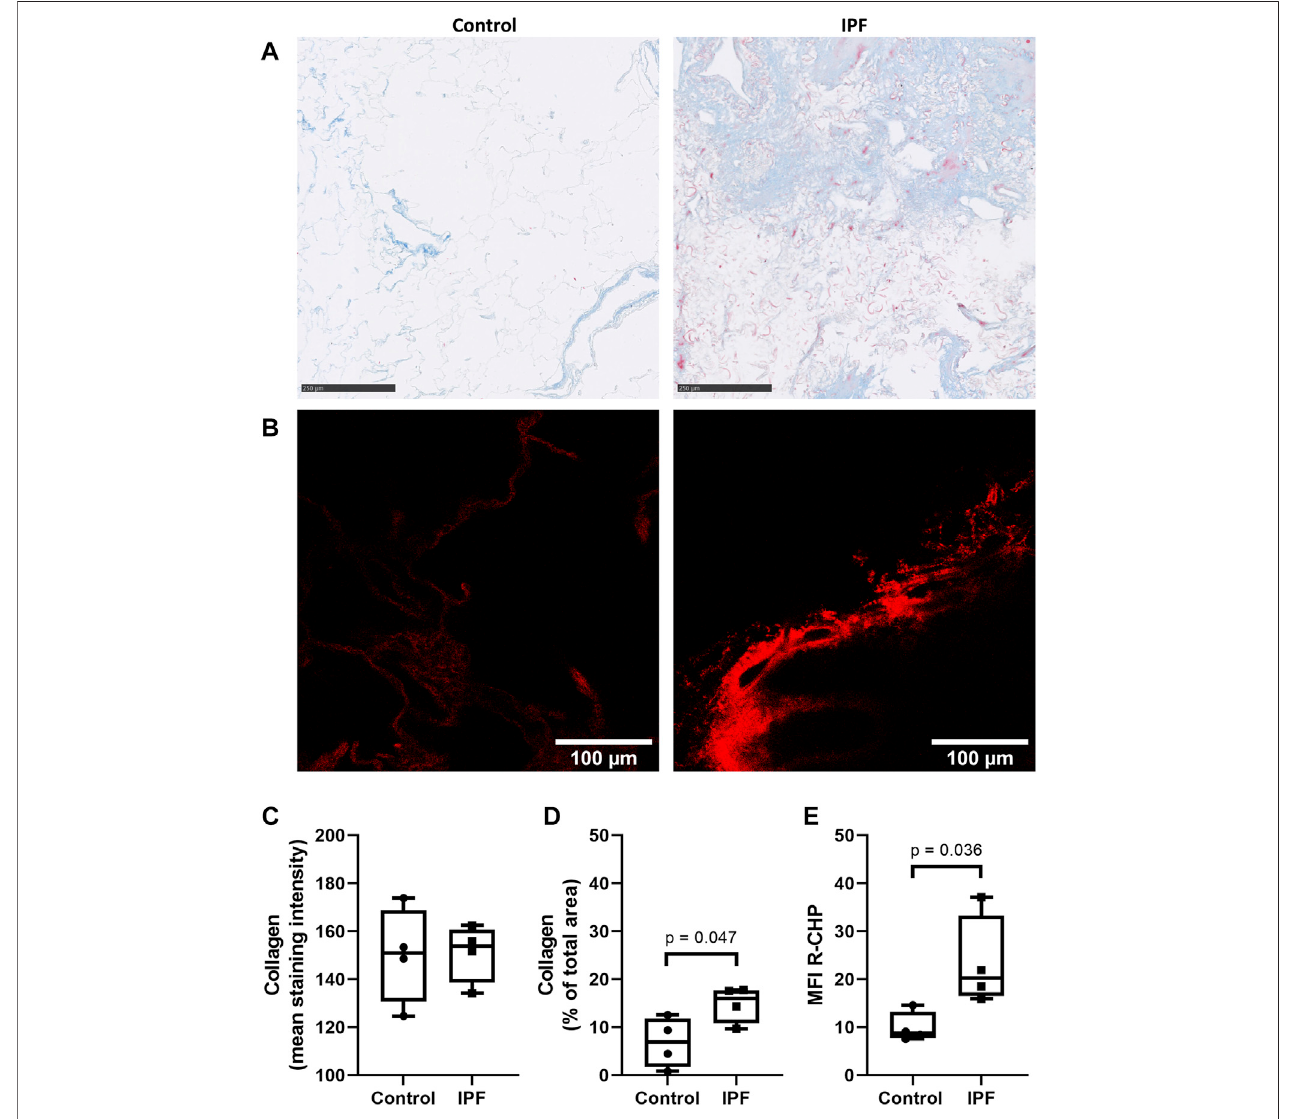
FIGURE 2 | Preservation of IPF-related difference in levels of denatured collagen after decellularization of lung tissue. Decellularized lung tissue was stained using Masson ’ s trichrome staining or Cy3-conjugated collagen hybridizing peptide (R-CHP). (A) Representative images of Masson ’ s trichrome stain in control lung tissue (left panel) and lung tissue of a patient with idiopathic pulmonary fi brosis (IPF, right panel), showing collagen fi bers in blue and cytoplasm in red. Magni fi ed part of the whole decellularized tissue section. Scale bar (cid:2) 250 µm. (B) Representative fl uorescence images of R-CHP signal in decellularized lung tissue from control patients (left panel) andfrompatientswithidiopathicpulmonary fi brosis(IPF,rightpanel). (C,D) Quanti fi cationoftheMasson ’ strichromestaining,showingthemeanstainingintensity (C) and therelativeamountofcollageninthewholeimagingarea (D) . (E) Quanti fi cation oftheR-CHP signal,showing theaveragemean fl uorescenceintensityofat least three images per decellularized lung tissue. One experimental replicate per subject, sample size n (cid:2) 4 for both control and IPF decellularized lung matrices. Data representedasmintomaxbox-and-whiskersplotsshowingallpoints.Groupswerecomparedusinganunpaired t -testafterassessingthenormaldistributionwithuseof a QQ plot and a Shapiro-Wilk normality test ( Supplementary Figure 2A ). p < 0.05 was considered signi fi cant.